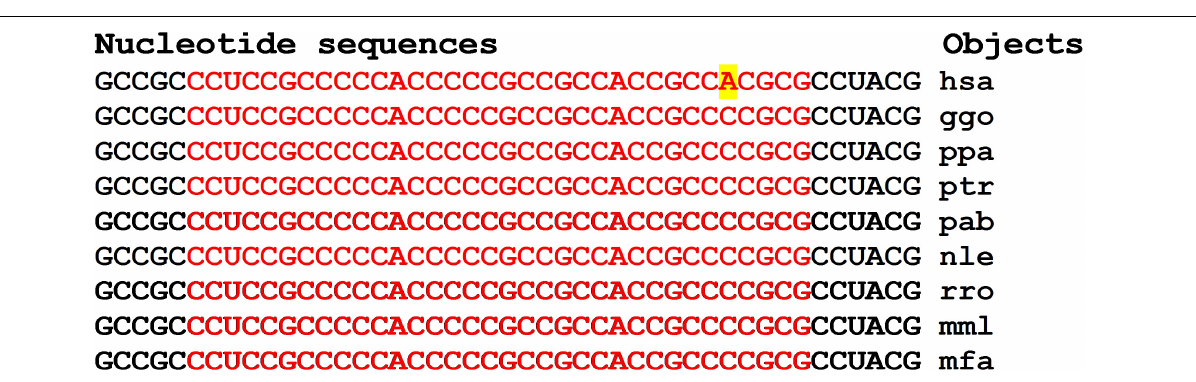
FIGURE 10 | Nucleotide sequences of the CDSs mRNAs regions of orthologous SETD1A genes containing clusters of miRNAs BSs.